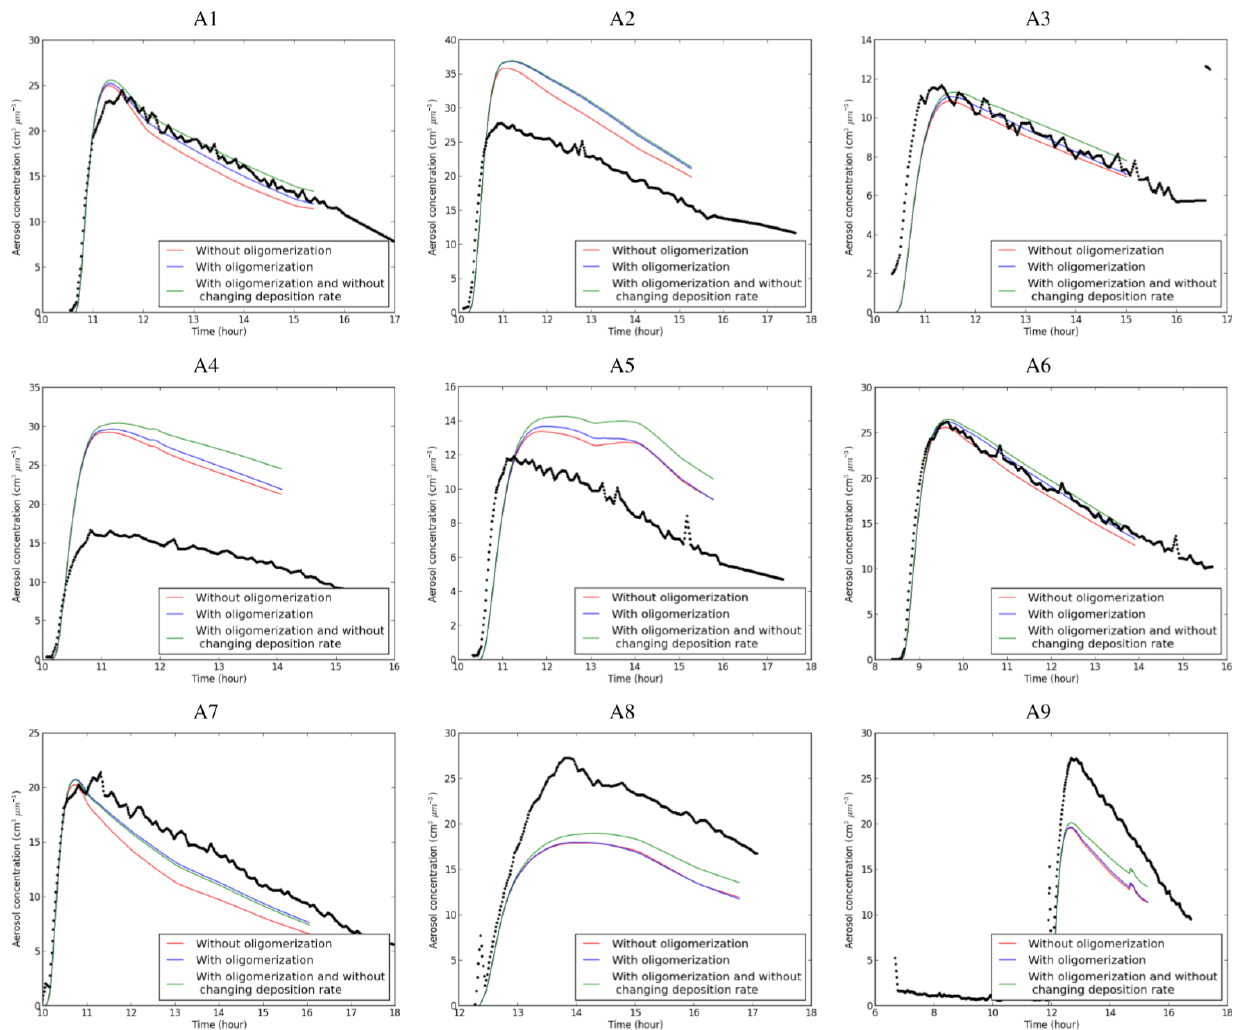
Figure 4. Aerosol concentration formation for the anthropogenic experiments. Black lines correspond to SMPS